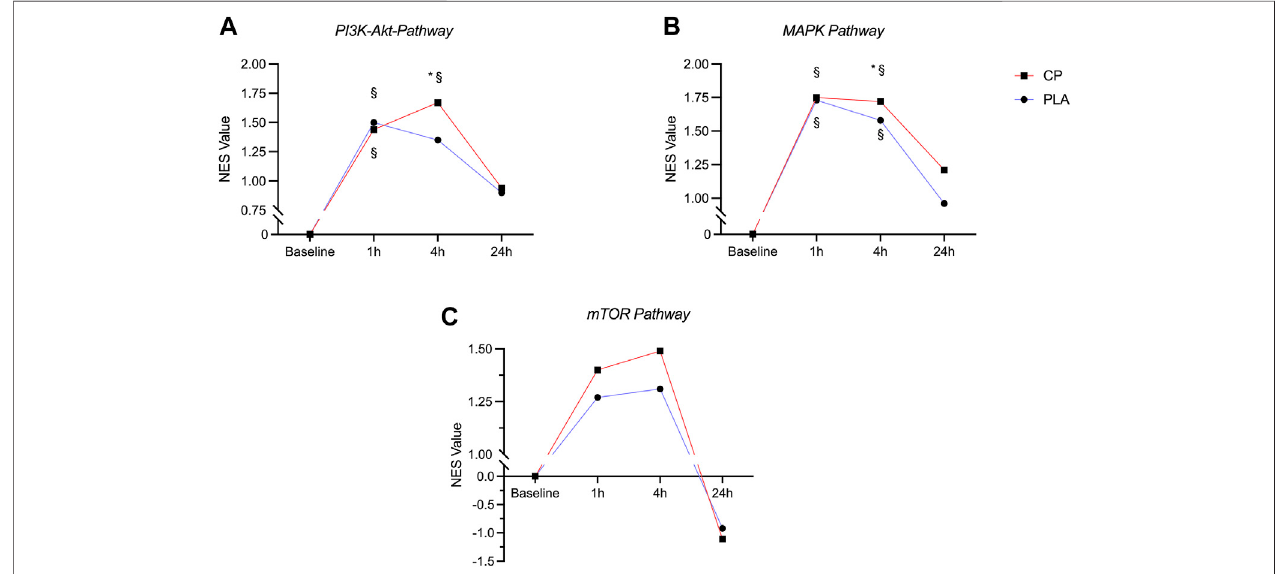
FIGURE 3 | Time course of the normalized enrichment scores (NES) in the PI3K-Akt-Pathway (A) , MAPK-Pathway (B) and mTOR pathway (C) in the collagen peptide (CP, n = 15) and placebo (PLA, n = 15) group. § = signi fi cantly different from baseline (p FDR < 0.05), * = signi fi cantly different from PLA (p FDR < 0.05).